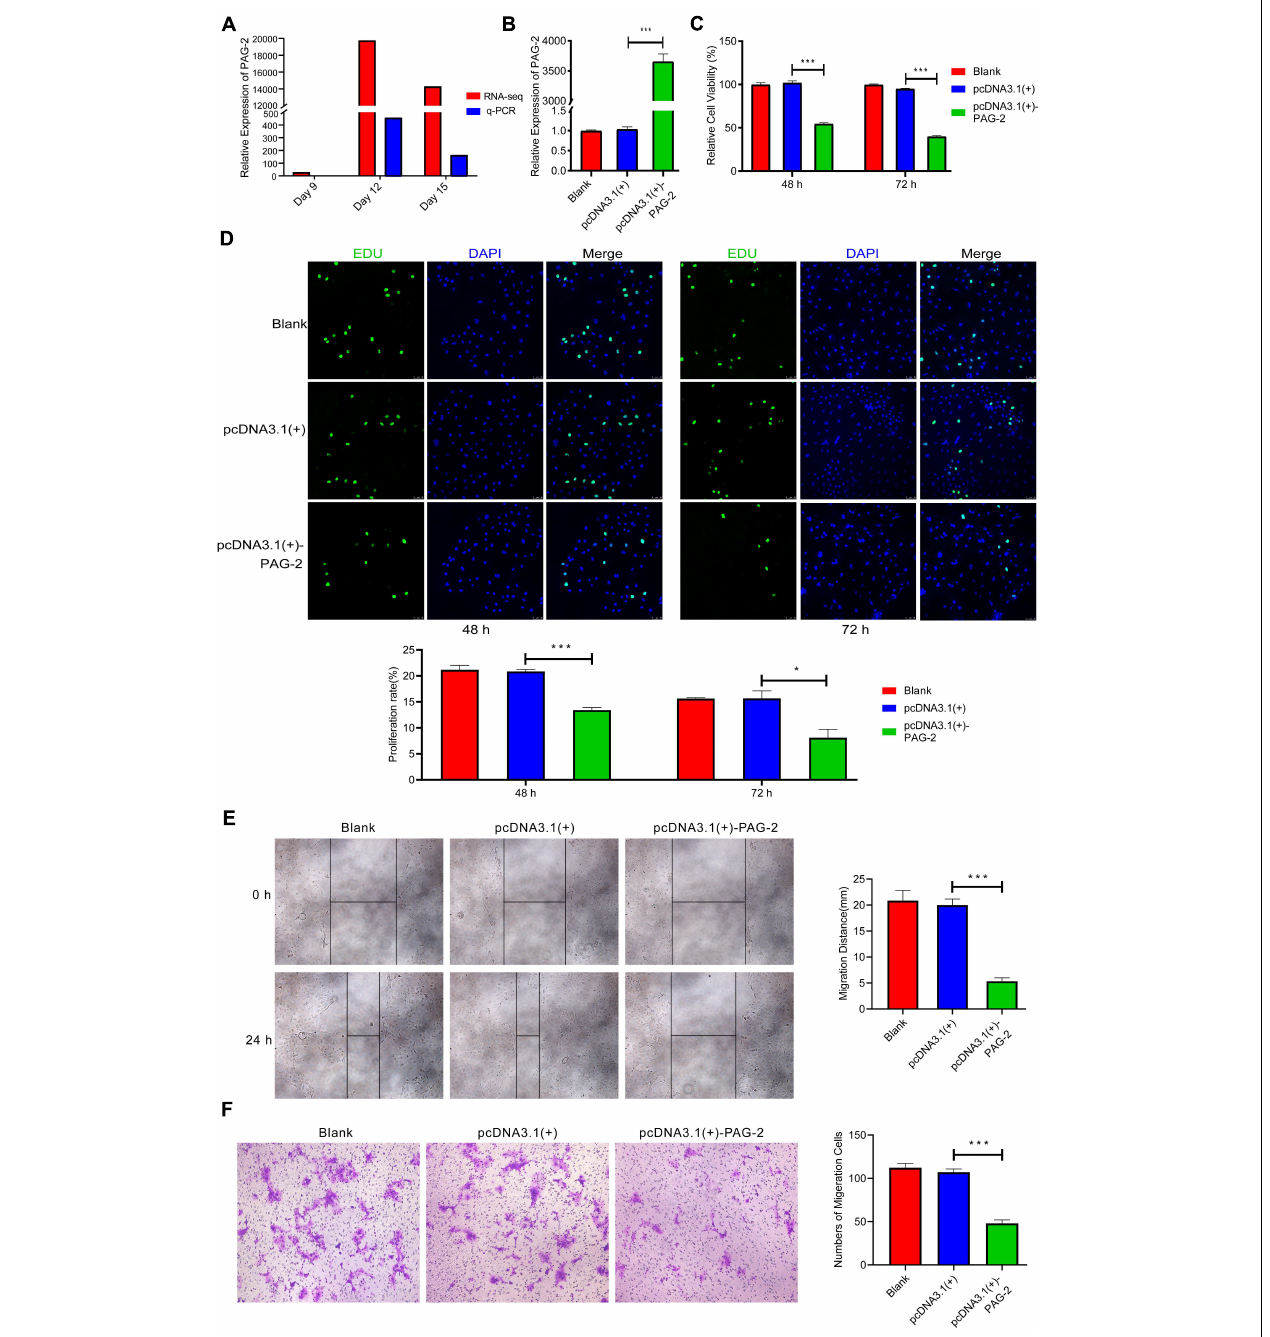
FIGURE 7 | PAG-2 inhibits cell proliferation and migration in vitro . (A) The expression level of PAG-2 in porcine conceptus at days 9, 12, and 15 of pregnancy. (B) Transfection efficiency of PAG-2 overexpression was determined by PCR. (C) The cell viability of PTr2 cells was applied by CCK-8 assay. (D) EDU staining assay was performed to determine the cell proliferation changes after PAG-2 overexpression. (E) Wound healing assay for the evaluation of migration of PTr2 cells. (F) Transwell migration assay showed that PAG-2 overexpression reduced the cell numbers of migration. CCK8, Cell Counting Kit-8. Data are presented as mean ± SEM. * P < 0.05, *** P < 0.001, and Student’s t -test.